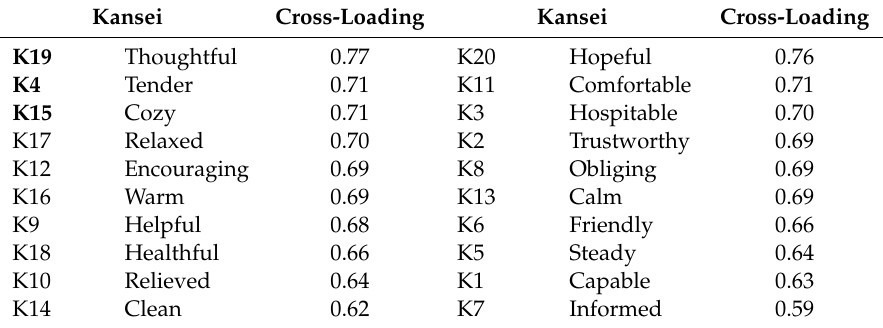
Table 4. Cross-loading of significant Kansei word on revisit